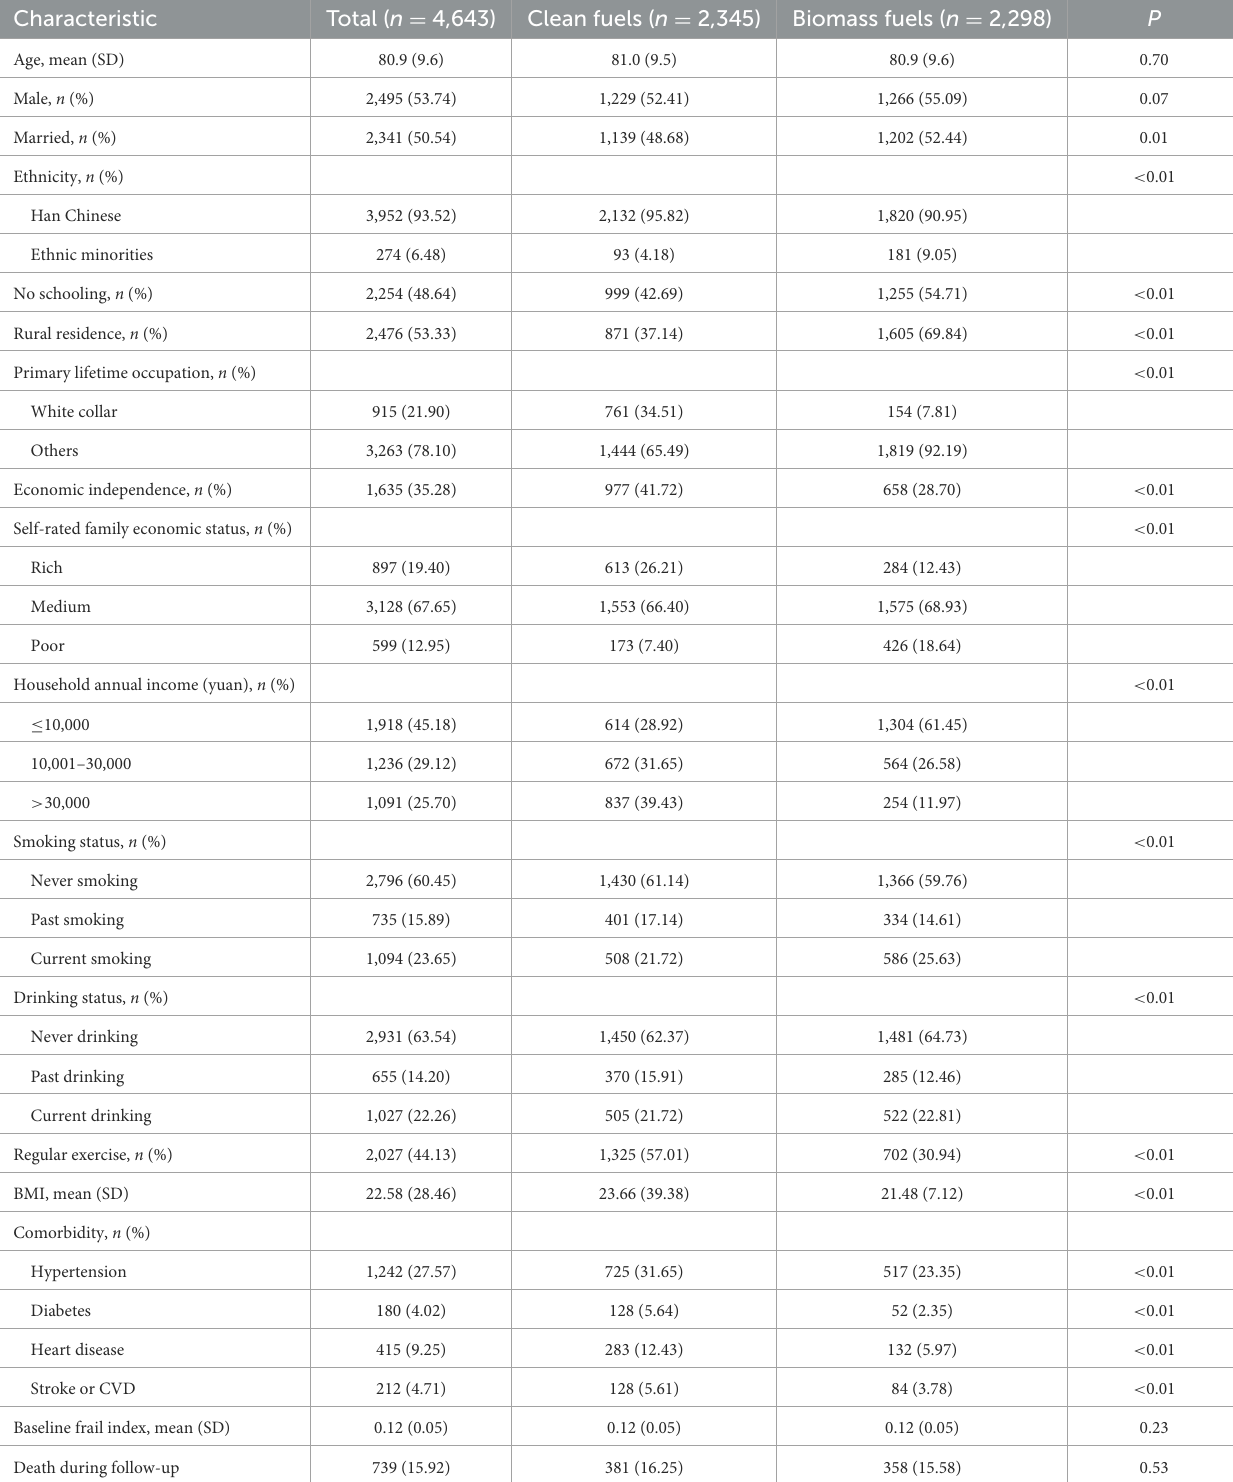
TABLE 1 Characteristics of participants according to cooking fuel types at baseline.